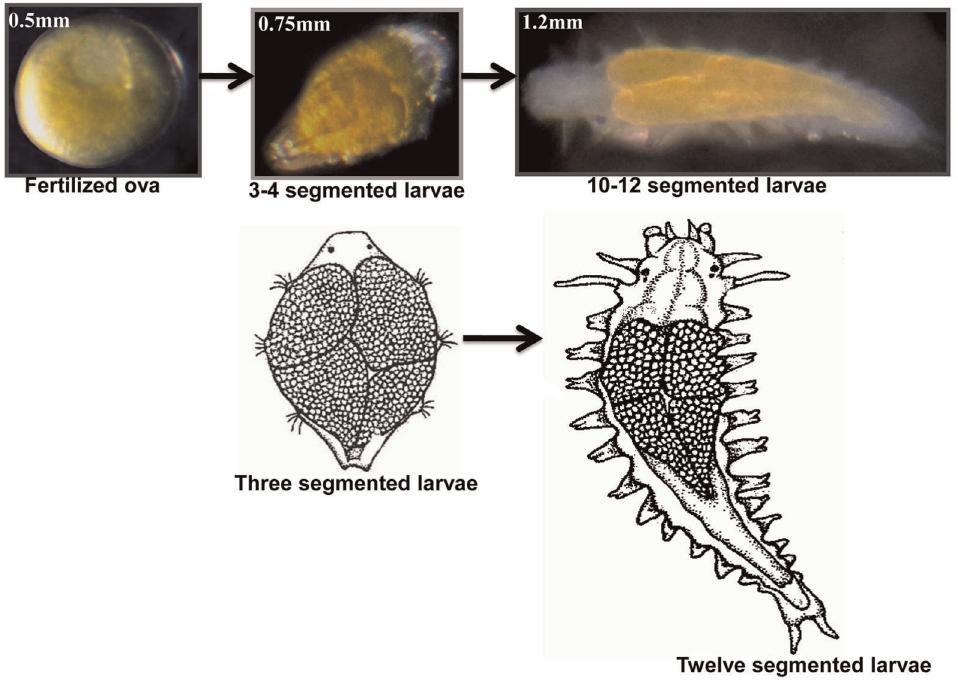
Figure 1. Early developmental stages of the polychaete Neanthesarenaceodentata . Three developmental stages were chosen for proteomic analysis: Fertilized ova, 3–4 segmented early larva and 10–12 segmented old larva. Drawings: Three segmented larva and twelve segmented larva.